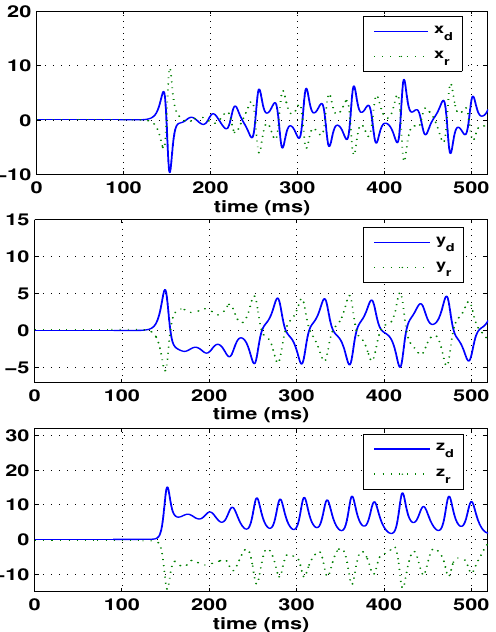
Figure 6. Observed state variables for the drive system ( x d , y d , z d ) and its response system ( x r , y r , z r ) evolution with time (ms) on the electronic workbench